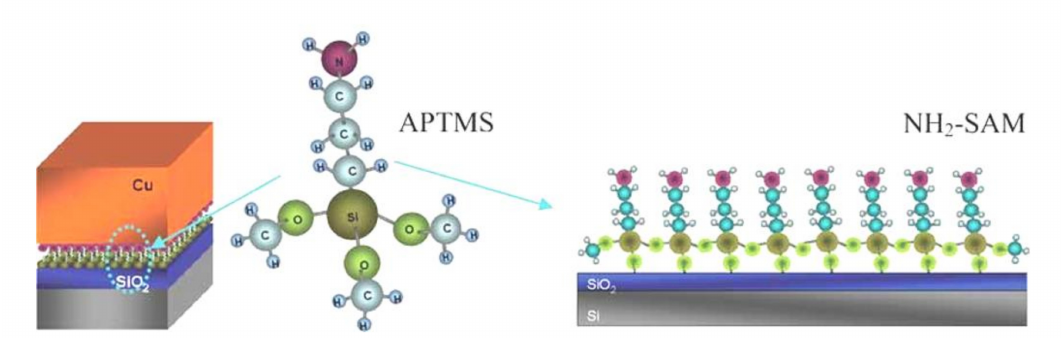
Figure 7. A schematic drawing of NH 2 -SAM (self-assembled molecular layer) barrier layer located in between Cu and SiO 2 . Reproduced from Caro et al. [106]. Copyright 2010 WILEY-VCH Verlag GmbH and Co. KGaA,